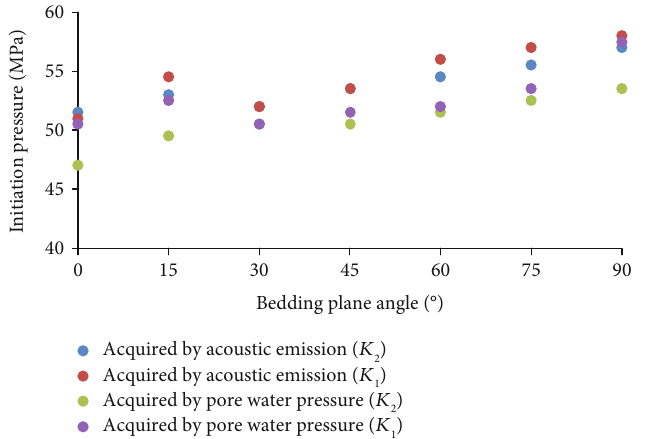
Figure 11: Initiation pressures acquired by pore water pressure nephogram or acoustic emission nephogram under di ff erent BP